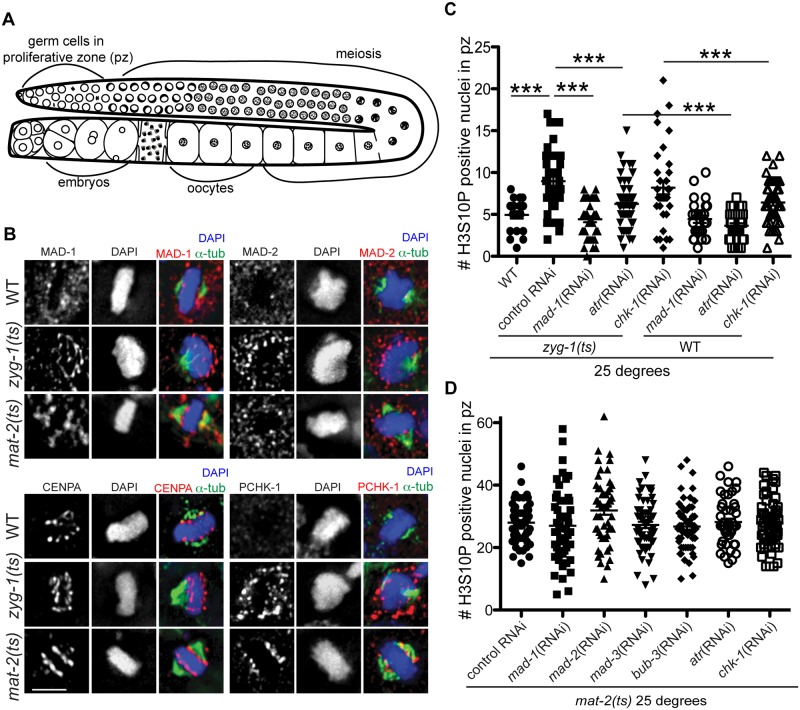
Both DDR and SAC components are responsive to metaphase perturbation.(A) Cartoon of C. elegans germ line (B) Wild-type, mat-2(ts), and zyg-1(ts) germ lines stained with MAD-1, MAD-2, CENPA or P-CHK-1(Ser344) (red), α-tubulin (green), and counterstained with DAPI (blue) following growth at 25°. Scale bars = 5μM. (C) Quantification of H3S10P-positive nuclei per germ line in wild-type and zyg-1(ts) worms treated with atr, chk-1, mad-1 or control (L4440) RNAi at 25° (n ≥ 20). zyg-1(ts) mean = 9.0 ±0.5 SEM vs. WT = 5.0 ±0.4, zyg-1(ts); mad-1(RNAi) = 4.4 ±0.3, zyg-1(ts); atl-1(RNAi) = 6.2 ±0.4, zyg-1(ts); chk-1(RNAi) = 9.1±0.5 p = 0.88; ***p<0.0001. (D) Quantification of H3S10P positive nuclei per germ line in mat-2(ts) worms grown at 25° treated with control, mad-1, mad-2, mad-3, bub-3, atr, or chk-1 RNAi (n≥48). H3S10P counts between mat-2(ts) and RNAi depletions were not significant except for mad-2(RNAi), which had more H3S10P than control RNAi, p = 0.02, indicating efficient arrest.